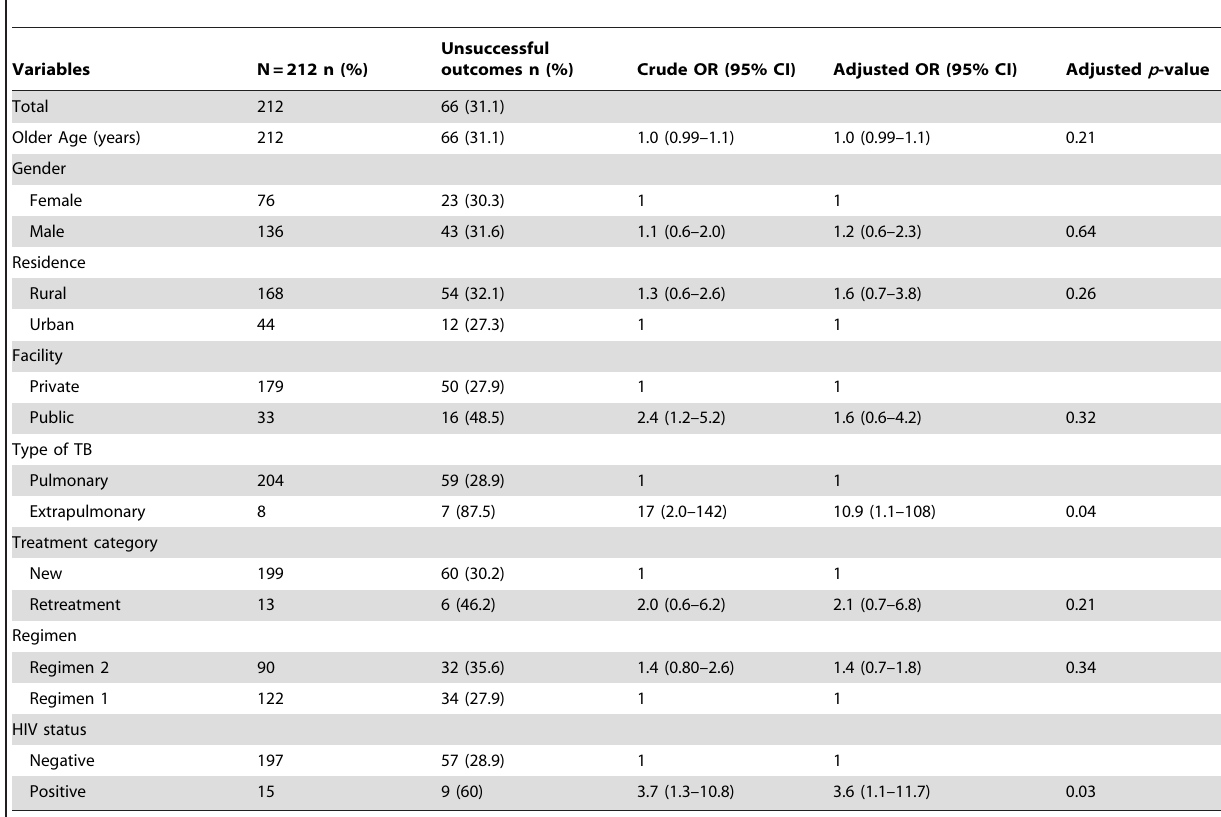
Table 4. Multivariable logistic regression analysis of factors associated unsuccessful treatment outcomes among elderly TB patients, Nigeria,